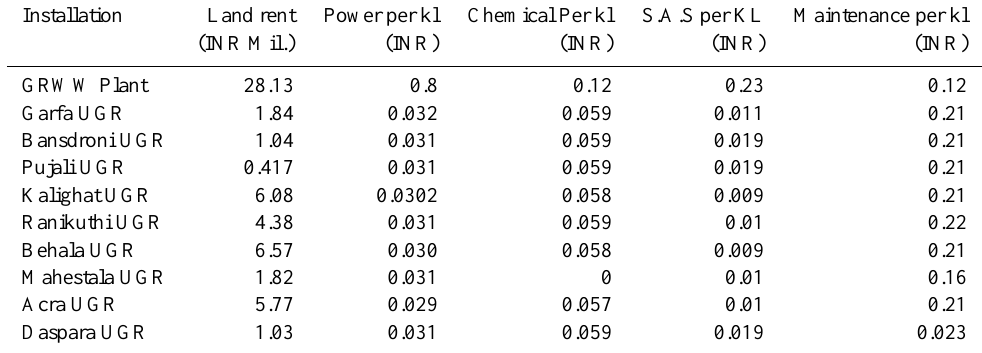
Table 3. Typical details of operating costs.